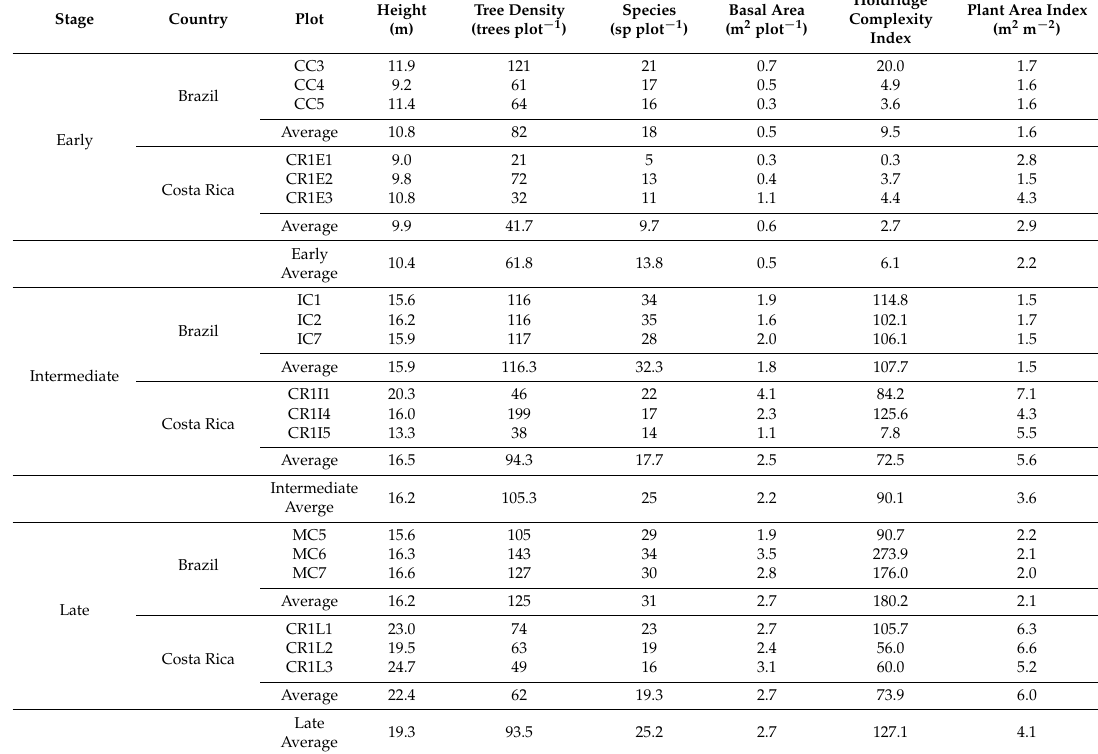
Table 4. Summary of the main structural parameters measured in different forest stages of dry forests in Costa Rica and